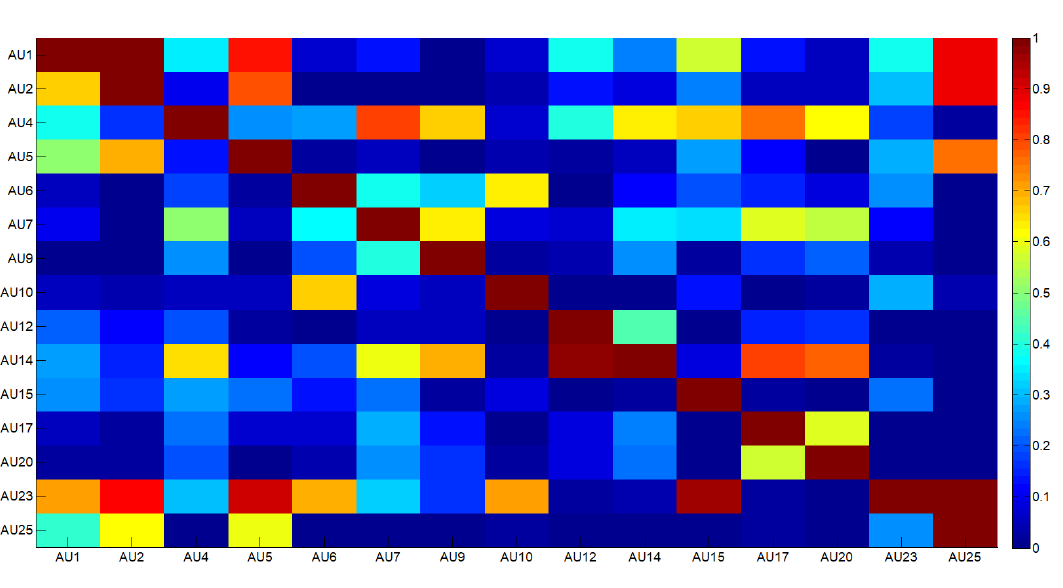
Figure 2. The learned joint probabilities among AUs.